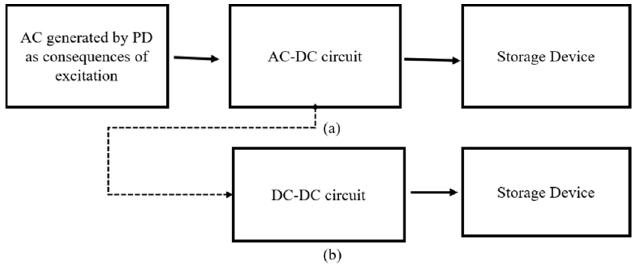
Figure 1. A summary of PEH process ( a ) . Single-stage, ( b ) . Dual-stage.